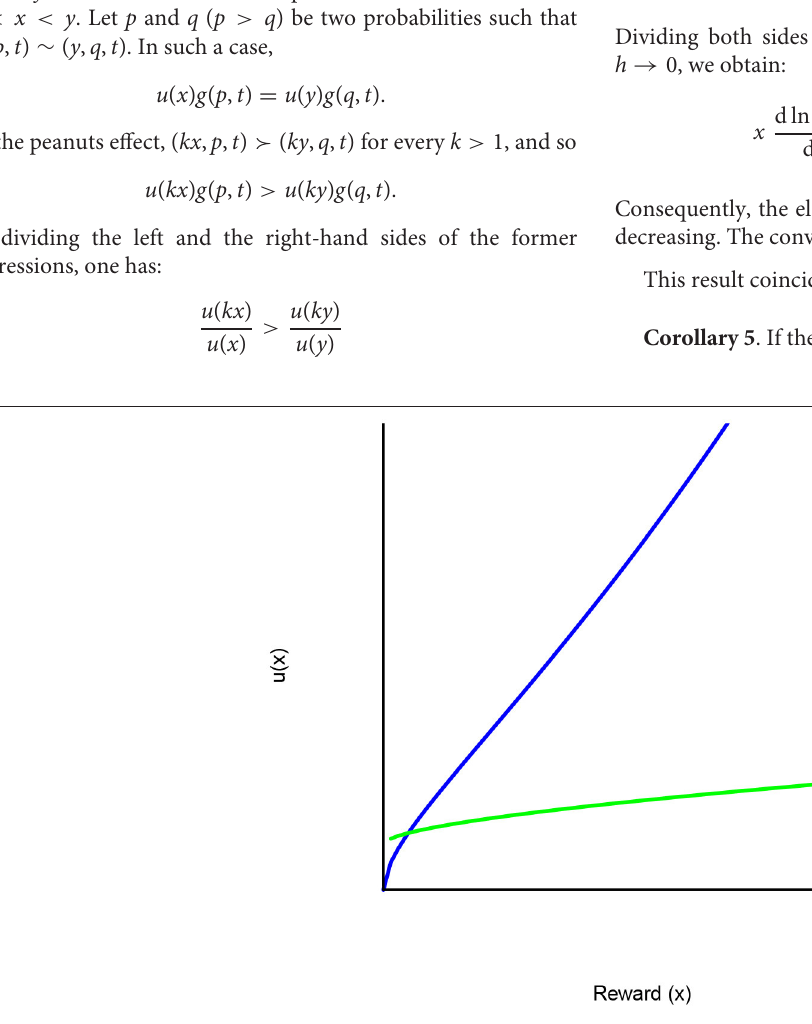
FIGURE 4 | Counterexample of corollary 5. Source: own elaboration.